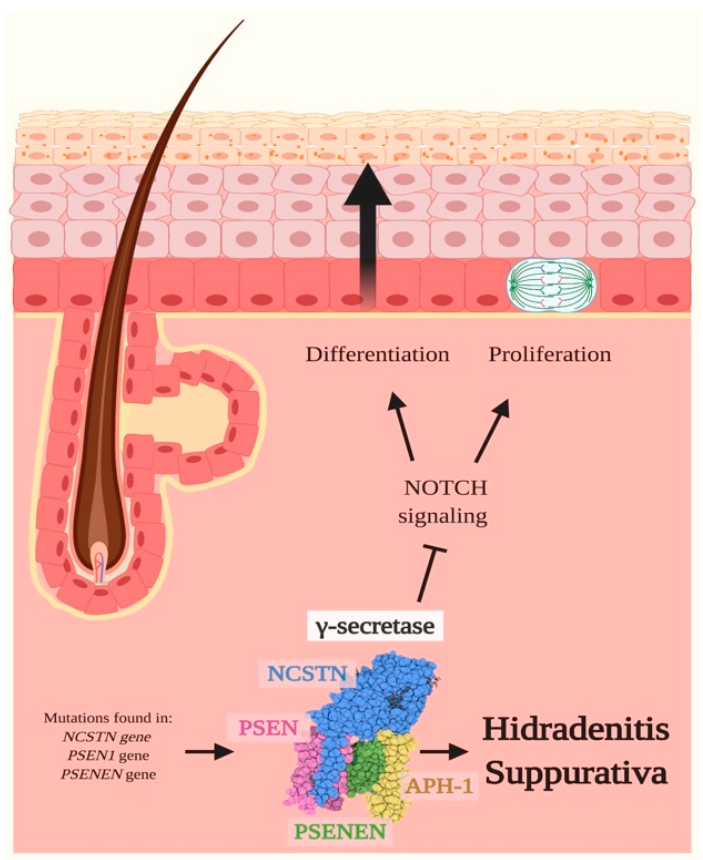
Figure 5. Hidradenitis Suppurativa and Notch signaling. Hidradenitis Suppurativa (HS) is a chronic inflammatory skin disease affecting the pilosebaceous unit, in which up to 35% of cases present a positive family history. These patients frequently carry mutations in NCSTN , PSEN1 and PSENEN genes, respectively encoding for nicastrin (NCSTN), presenilin 1 (PSEN) and presenilin enhancer 2 (PSENEN) (encoding for protein). These genes encode for three of the four subunits of the γ -secretase multiprotein complex, a transmembrane protease involved in the cleavage of Notch receptors, and their haploinsufficiency results in the dysfunction of the complex. As a consequence, the γ -secretase is not able to cleave and activate Notch receptors and therefore induces an impairment of Notch signaling, ultimately resulting in augmented levels of epidermal cell proliferation and di ff erentiation. Therefore, alterations in Notch signaling might underlie, at least partially, the initial steps of HS onset, which includes infundibular hyperkeratosis and hyperplasia of follicular epithelium that anticipate the follicular occlusion and disruption. Pointed arrows ( → ) define the induction of the indicated process or associated function, while the truncated arrow (T) designates the inhibition of the described process.